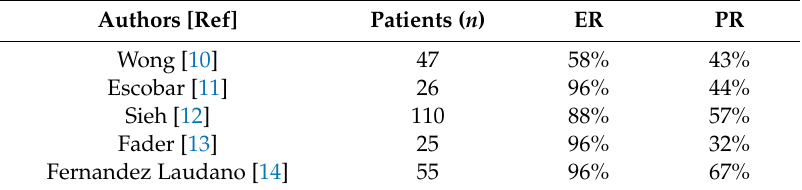
Table 1. Estrogen receptor (ER) and progesterone receptor (PR) expression in low-grade serous ovarian